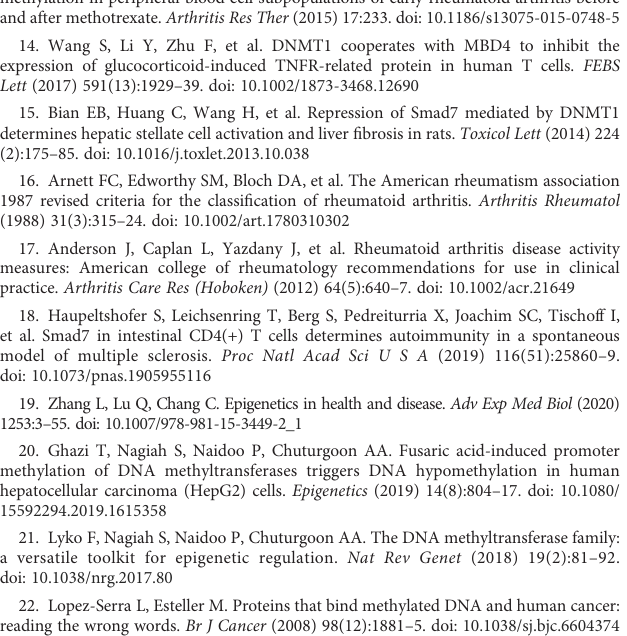
SUPPLEMENTARY FIGURE 1 Smad7 promoter methylation sequencing line diagram in peripheral CD4 + T cells of RA and healthy controls (HC). SUPPLEMENTARY FIGURE 2 MechanismdiagramofSmad7DNAmethylationregulationinRApathology.The binding of methyltransferases DNMTs to the promoter region of Smad7 inhibits the effect of demethylated MBDs, leading to the decreased expression of Smad7. The decreased expression of Smad7 affected the immune balance of CD4 + T cells though mediating aberrant Th17/Treg ratio, which leaded to the progression of